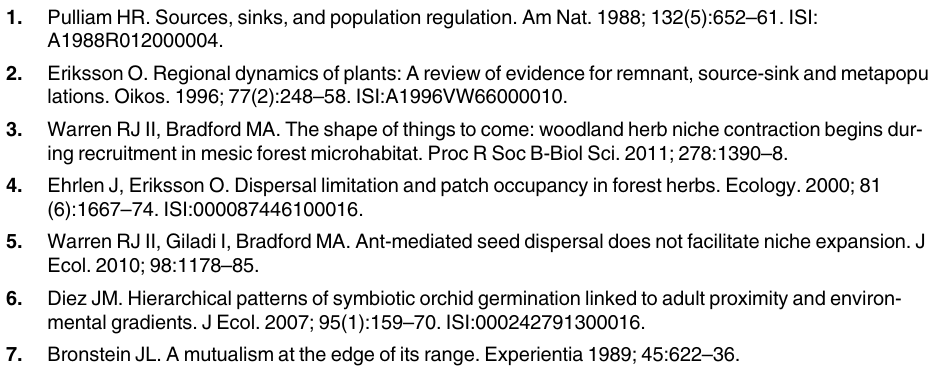
S1 Fig. Second surveys. Barplots showing Gleditsia triacanthos abundance in Cherokee and control sites from 2014 sampling and G . triacanthos distance from Cherokee and control sites using data from the All Taxa Biodiversity Inventory. S1 Table. Site characteristics. Environmental variables across sites and habitat